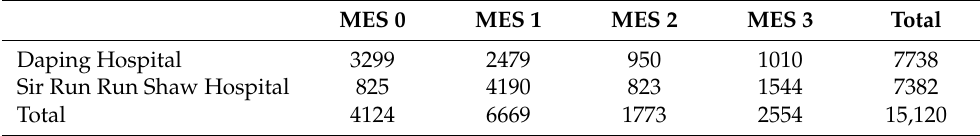
Table 1. The specific data